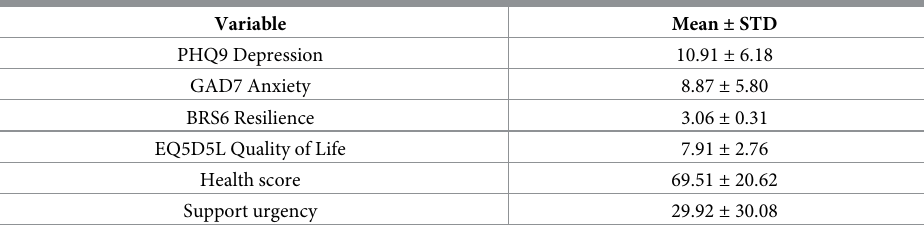
Table 5. Descriptive analysis on decision variables (N =